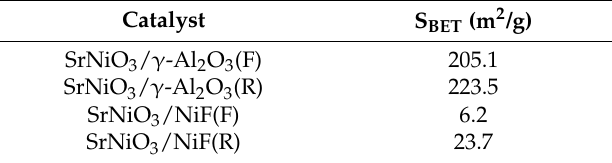
Table 1. Brunauer–Emmett–Teller (BET) surface area of the different supported catalysts.